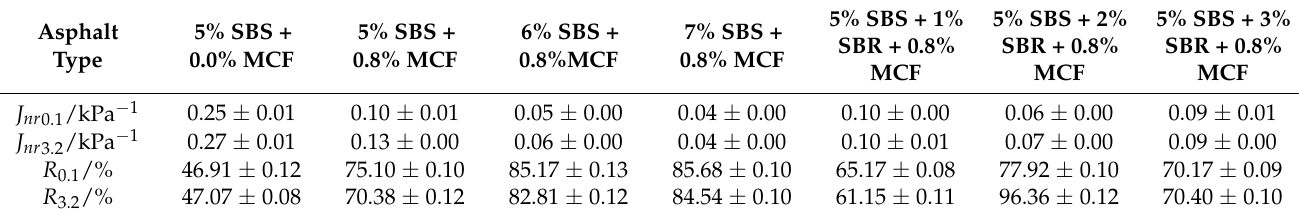
Table 8. MSCR test results of the modified asphalts.